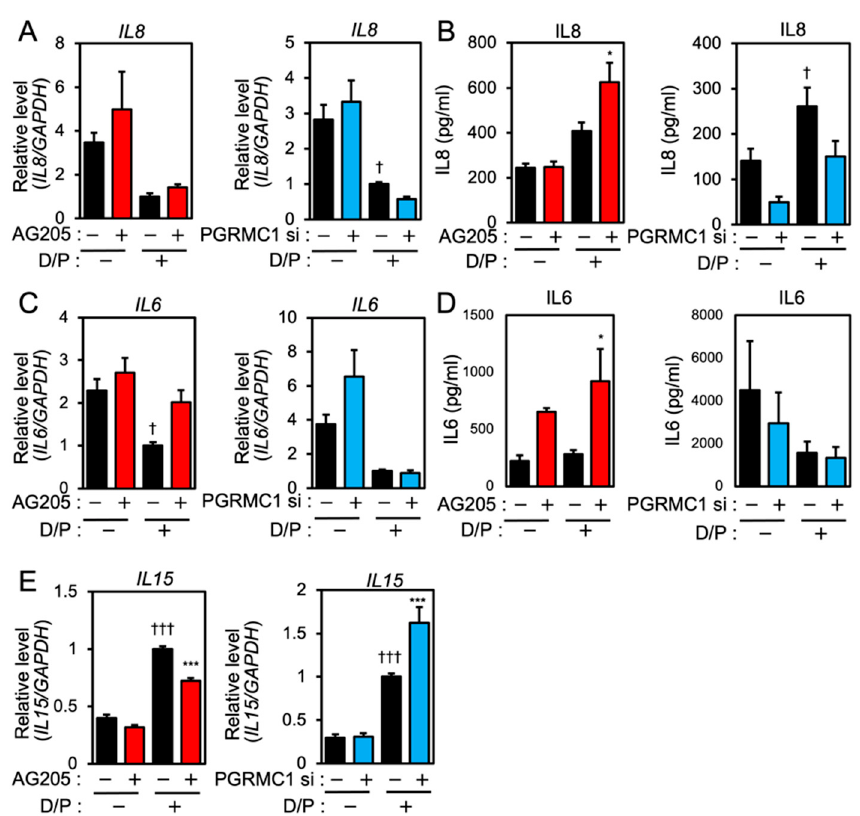
Figure 2. PGRMC1 inhibition and knockdown alter the expression of SASP-related ILs in ESCs. ESCs were pre-treated with the PGRMC1 inhibitor AG-205 (10 μ M) for 1 h or PGRMC1 siRNA for 1 day and then stimulated with D/P for 2 days. IL8 ( A ), IL6 ( C ), and IL15 ( E ) mRNA levels were determined by real-time RT-PCR. GAPDH was used as the reference gene. ††† p < 0.001 vs. control. *** p < 0.001 vs. D/P. IL8 ( B ) and IL6 ( D ) secreted into the cell culture medium were analyzed with ELISA. Red and blue bars show the AG205-treated and PGRMC1 siRNA-transfected group, respectively. * p < 0.05 vs. D/P. † p < 0.05 vs. control.